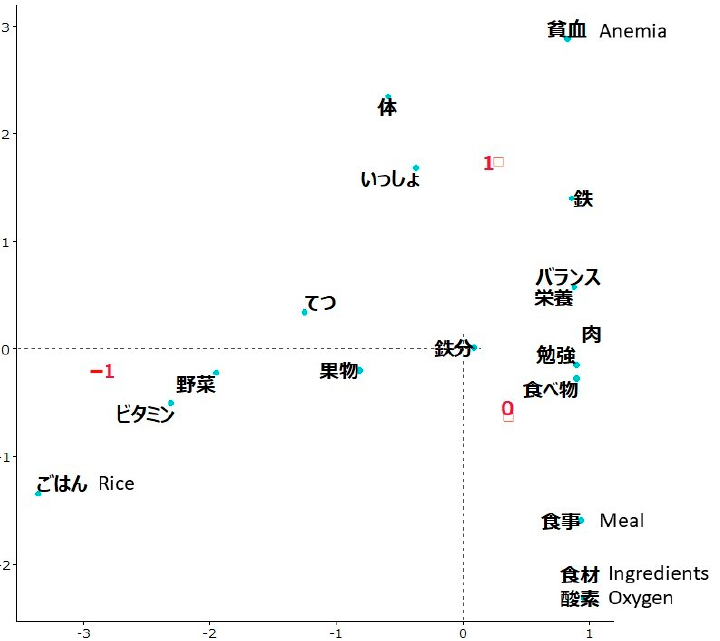
Figure 4. Correspondence analysis of words used in students’ opinions about the FOOD workshop depending on changes in the evaluation indicator rating. The group with an increased rating of the workshop evaluation indicator was labeled as 1, no change in rating as 0, and a decreased rating